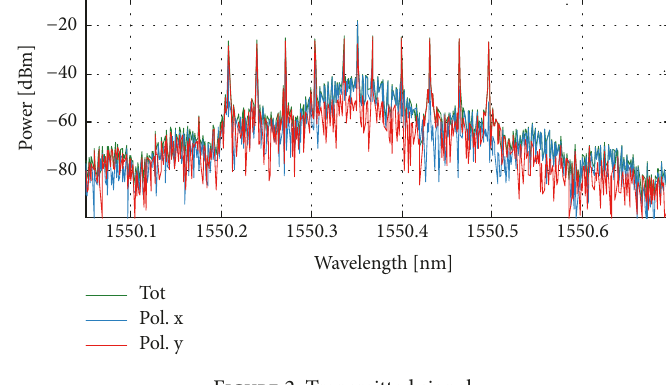
Figure 2: Transmitted signal.